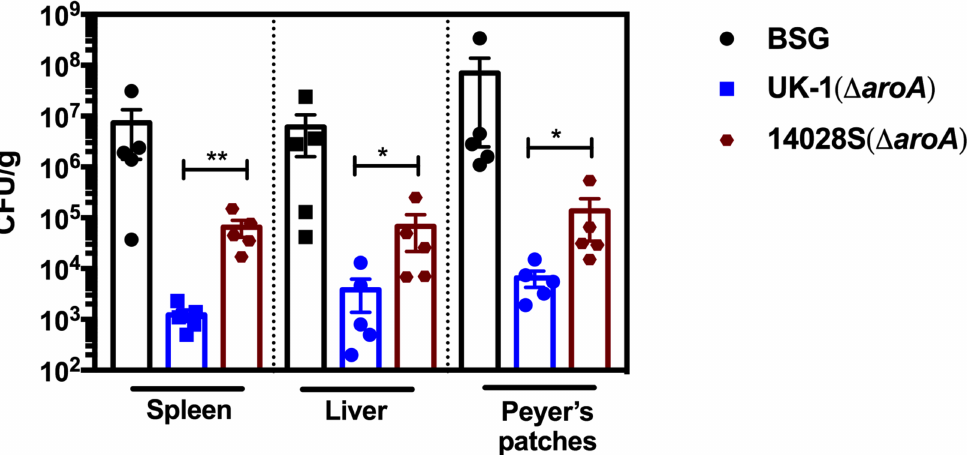
Fig 6. UK-1 burdens are controlled efficiently by UK-1( Δ aroA ), but not 14028S( Δ aroA ). BALB/c mice ( n = 5) were orally immunized with UK-1( Δ aroA ), 14028S( Δ aroA ) or BSG (mock) on day 0 and orally challenged with UK-1 or 14028S on day 35. Spleen, liver, and Peyer’s patches were collected on day 6 post challenge to determine the bacterial burdens. UK- 1 burdens were significantly reduced in all target organs when mice were immunized with UK-1( Δ aroA ), but not when immunized with 14028S( Δ aroA ), as compared to mock-vaccinated mice. (cid:3) P (cid:20) 0.05, (cid:3)(cid:3) P (cid:20)